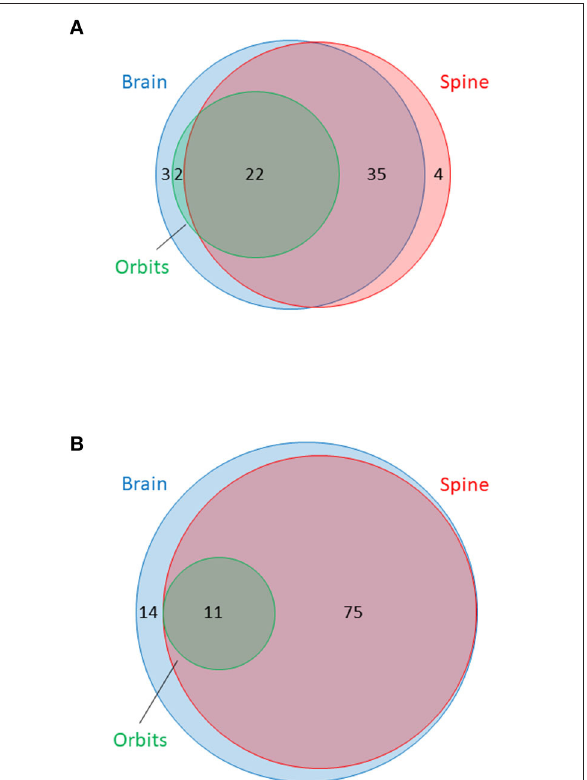
FIGURE 3 | Venn diagram summarising availability of MRI of brain, orbits and spine in (A) NMOSD cases and (B) multiple sclerosis cases. Surface area of circles is proportional to the total number of MRI of each type. MRI brain in blue, orbits in green and spine in red. Numbers indicate numbers of patients with at least one MRI of specified type within each category or overlapping